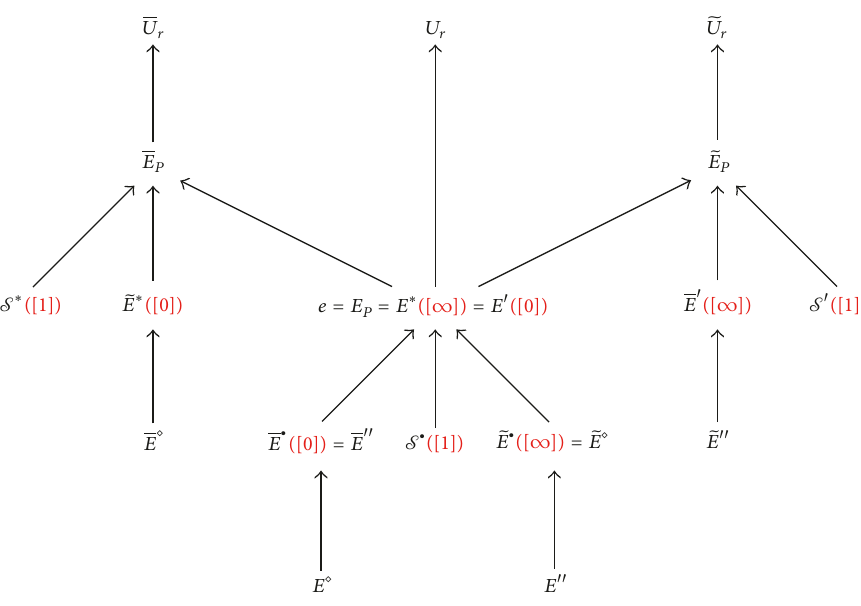
̃ E ch whenever 𝑒 = 𝐸 푃 .